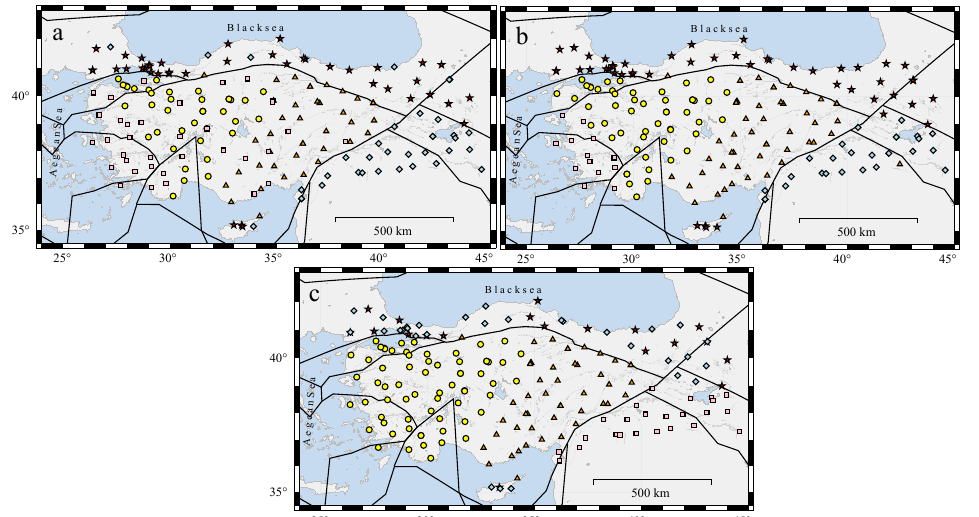
Figure 6. Ensemble results gathered from five clustering algorithms for horizontal GPS-derived velocity field with: ( a ) HGBF; ( b ) MCLA; ( c ) NMF methods. Black solid lines are the block model at [5]. Gray thin lines show active faults [23].